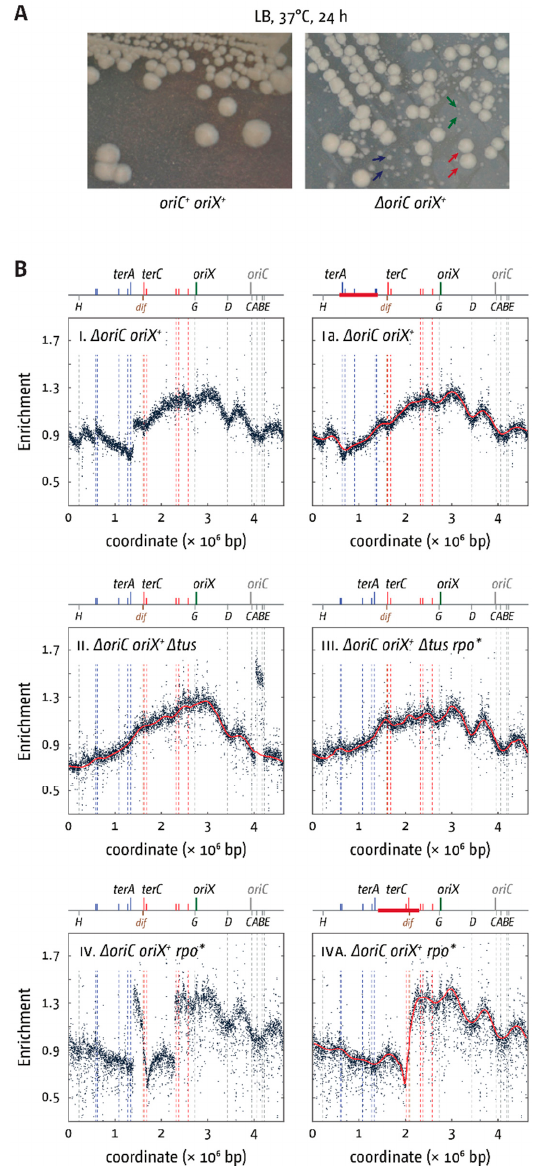
Figure 5. Growth and replication profiles of E. coli cells replicating from a single ectopic replication origin. ( A ) Large colony variants due to accumulation of suppressor mutations in ∆ oriC oriX + cells. Shown is a streak to single colonies of an overnight culture of both constructs. While an oriC + oriX + strain shows largely uniform colony sizes with only some variation due to colony density, a ∆ oriC oriX + construct shows small, medium, and large colonies, as highlighted by green, blue, and red arrows, respectively. The strains used were JD1181 ( oriC + oriX + ) and JD1187 ( ∆ oriC oriX + ). ( B ) Replication profiles of E. coli cells with a single ectopic replication origin. Shown is the MFA of E. coli ∆ oriC oriX + , ∆ oriC oriX + ∆ tus, ∆ oriC oriX + rpo* , and ∆ oriC oriX + ∆ tus rpo* cells. The number of reads (normalised against reads for a stationary phase wild-type control) is plotted against the chromosomal location. A schematic representation of the E. coli chromosome showing positions of oriC and oriZ (green line) and ter sites (above), as well as dif and rrn operons A–E , G , and H (below), is shown above the plotted data. Clear discontinuities of the profiles can be seen in panels i, ii, and iv. For panels i and iv, these are due to large inversions, as highlighted by the continuous replication profile that results if the area highlighted in red in the schematic representation of the chromosome is inverted. The strains used were JD1187 ( ∆ oriC oriX + ), JD1208 ( ∆ oriC oriX + ∆ tus ), JD1197 ( ∆ oriC oriX + rpo* ), and JD1209 ( ∆ oriC oriX + ∆ tus rpo*